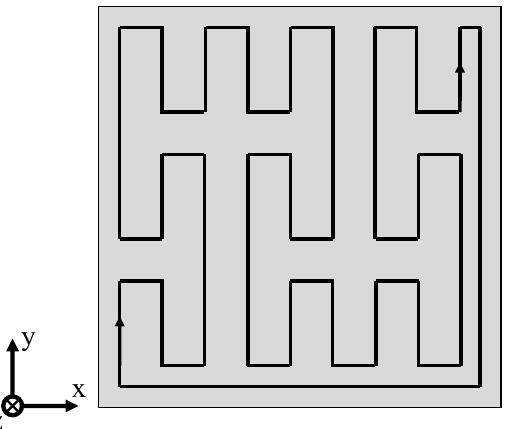
Figure 4. Fractal, quasi-simultaneous exposure pattern of a distinct sub-segment based on the Peano curve.